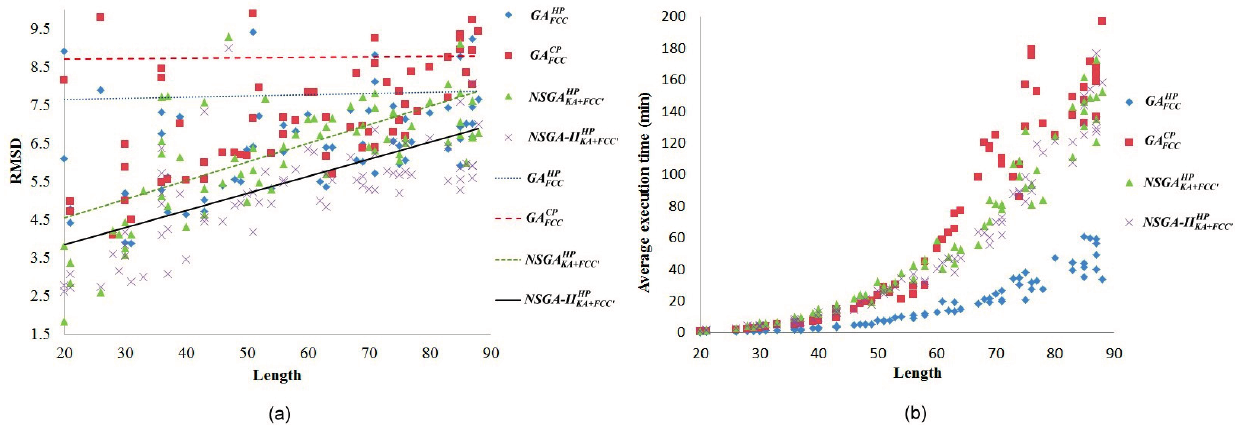
Figure 1. ( a ) Root-mean-square deviation (RMSD) comparison among four objective functions; ( b ) Comparison of running time complexity among four objective